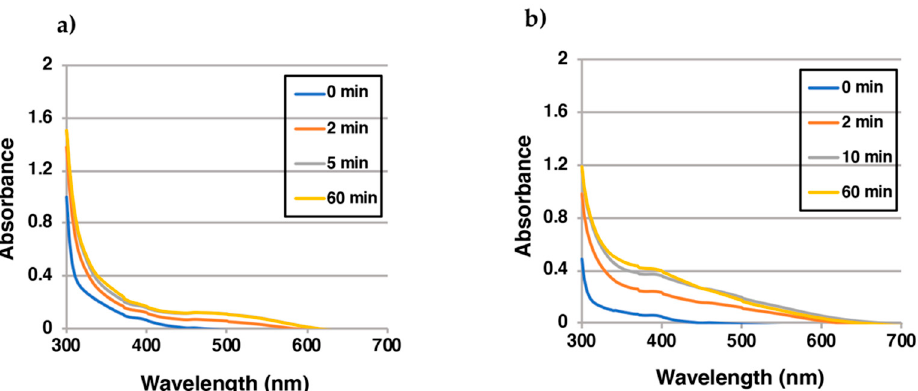
Figure 4. Time course of the tyrosinase-catalyzed oxidation of 3’-hydroxy-EQ 2 in the presence of BSA. ( a ) UV/visible spectral changes of 3’-hydroxy-EQ 2 in the presence of 3 mol eq. BSA (containing 0.90 mol eq. SH group) at pH 6.8; ( b ) UV/visible spectral changes of 3’-hydroxy-EQ 2 in the presence of 3 mol eq. NEM-modified BSA at pH 6.8. Data were obtained from single experiments, but reproducibility was confirmed for each experiment.